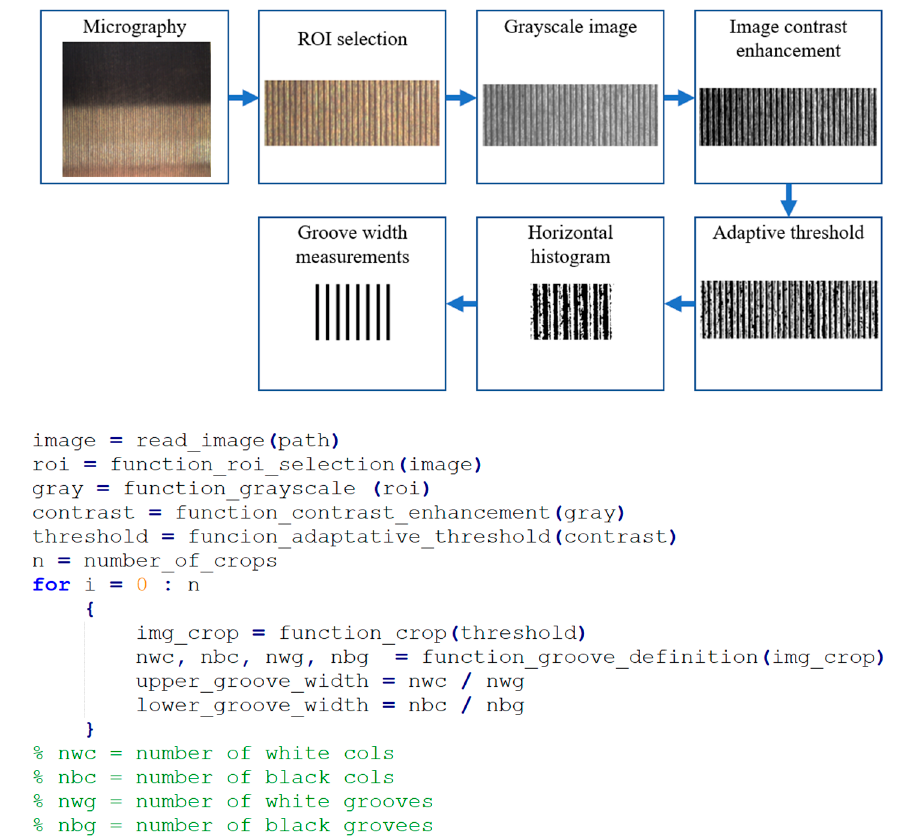
Figure 7. Process followed for image analysis: ( a ) diagram showing the different steps of image processing to achieve the measurement of the grooves in the workpiece; ( b ) pseudocode indicating the steps followed by the automated image processing algorithm.